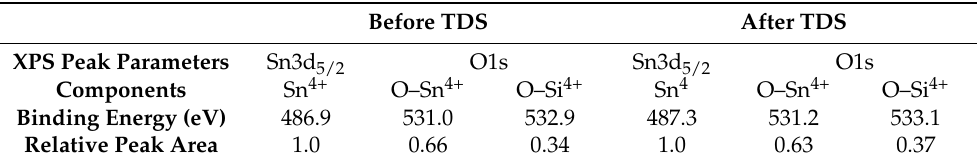
Table 2. The basic parameters of XPS Sn3d 5/2 and O1s peaks used in the deconvolution procedure and the obtained contribution of the main components for the samples both before as well as after TDS.